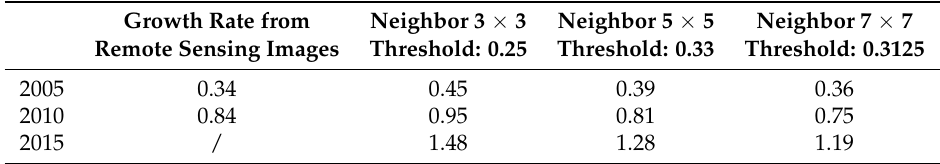
Table 5. Comparison between observed and simulated urban growth rates.